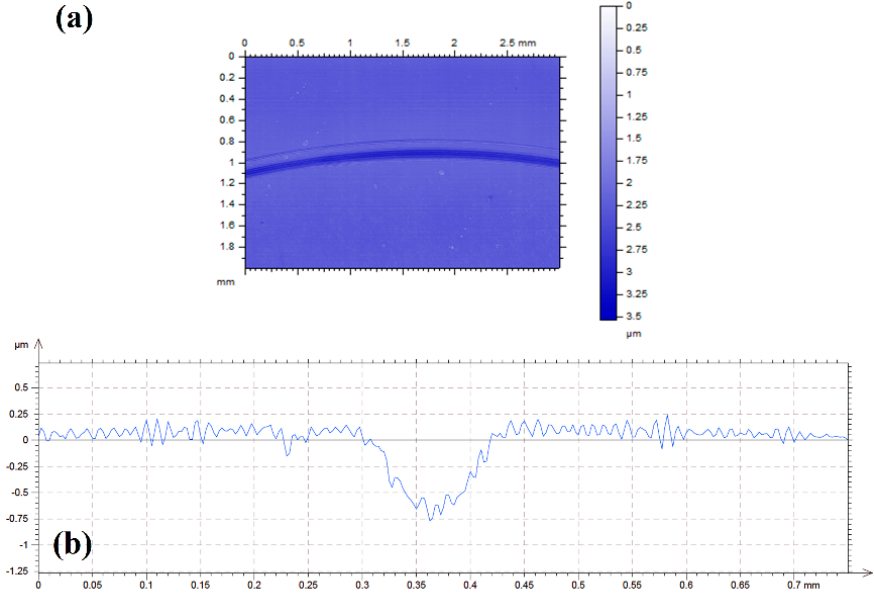
Figure 9. ( a ) Surface topography and ( b ) cross sectional profile of the wear track on AISI 316L disk after lubrication with base oil.